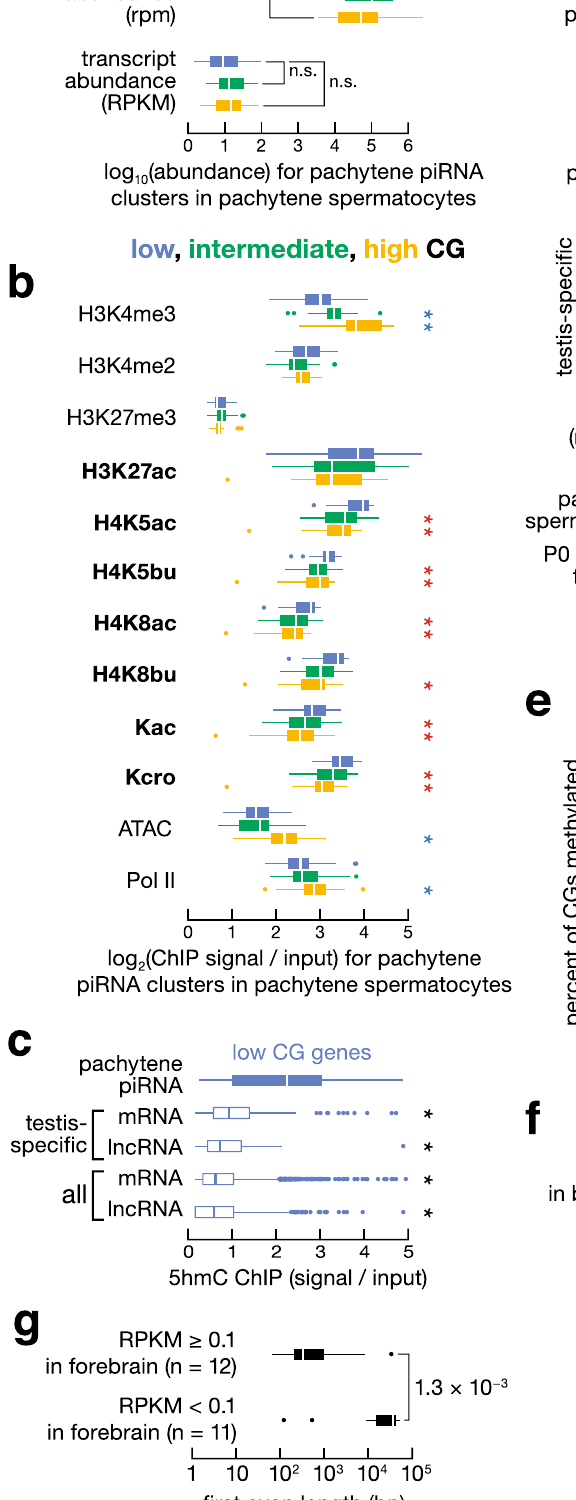
exon length = 35,227 vs. 308; Wilcoxon rank-sum test p value